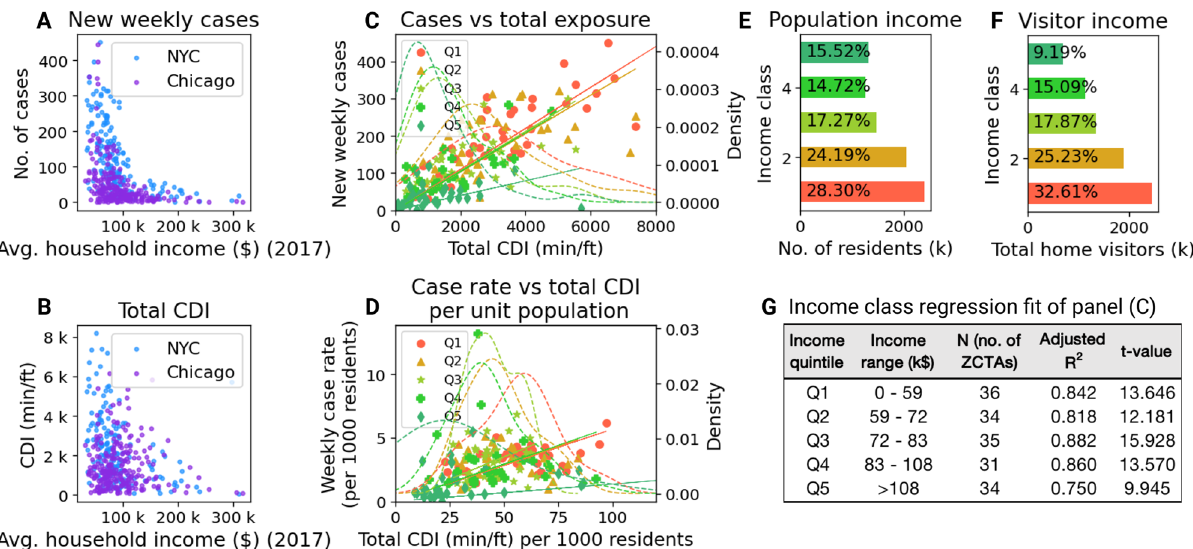
Figure 3. Relationship between cases, CDI, and income of ZCTAs during the exemplary week of 20-26 April. Income versus ( A ) total CDI and ( B ) new positive cases in NYC and Chicago; ( C ) New cases versus total CDI in NYC, colored by income quintile, along with the probability density distribution of ZCTAs by income quintile; ( D ) same as ( C ) but with values divided by ZCTA population. For reference, distributions of ( E ) population of ZCTAs of NYC and ( F ) the weekly number of visitors are also shown. ( G ) Description of income quintiles and ordinary linear regression results in panel ( C